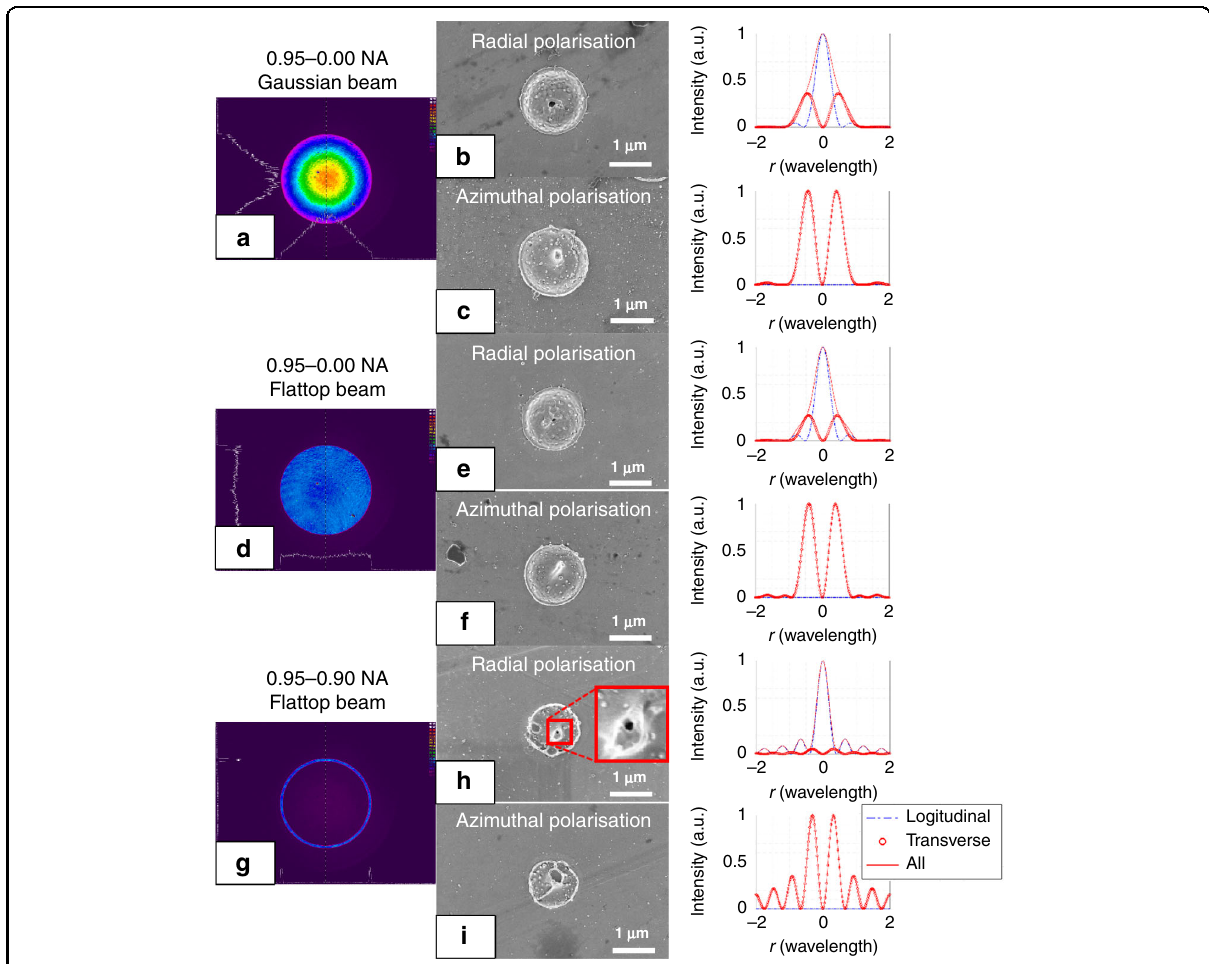
Fig. 3 Comparison of effect of beam pro fi le and polarisation state on laser ablation on copper. a , d , g Collimated laser beam intensity cross- section shaped into 0.95 – 0.00 NA Gaussian beam, 0.95 – 0.00 NA fl attop beam, and 0.95 – 0.90 NA annular beam and detected by using a beam pro fi ler. b , c , e , f , h , i Effect of single pulse ablation on polished copper and the result of relative focal spot modelling under radial and azimuthal